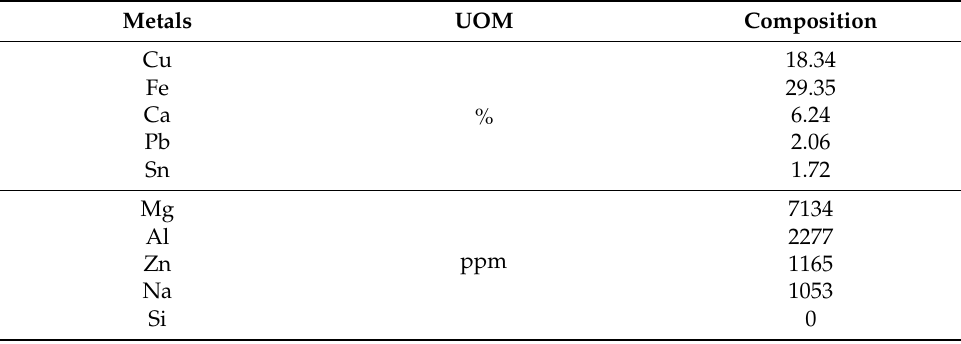
Table 1. Chemical compositions of the copper sludge